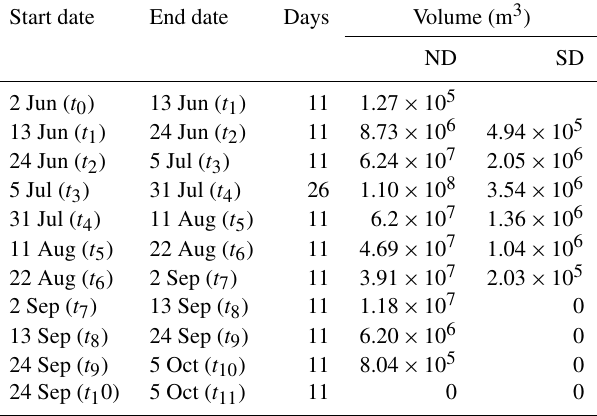
Table 3. Total volume of subglacial discharge modelled per period of calving front